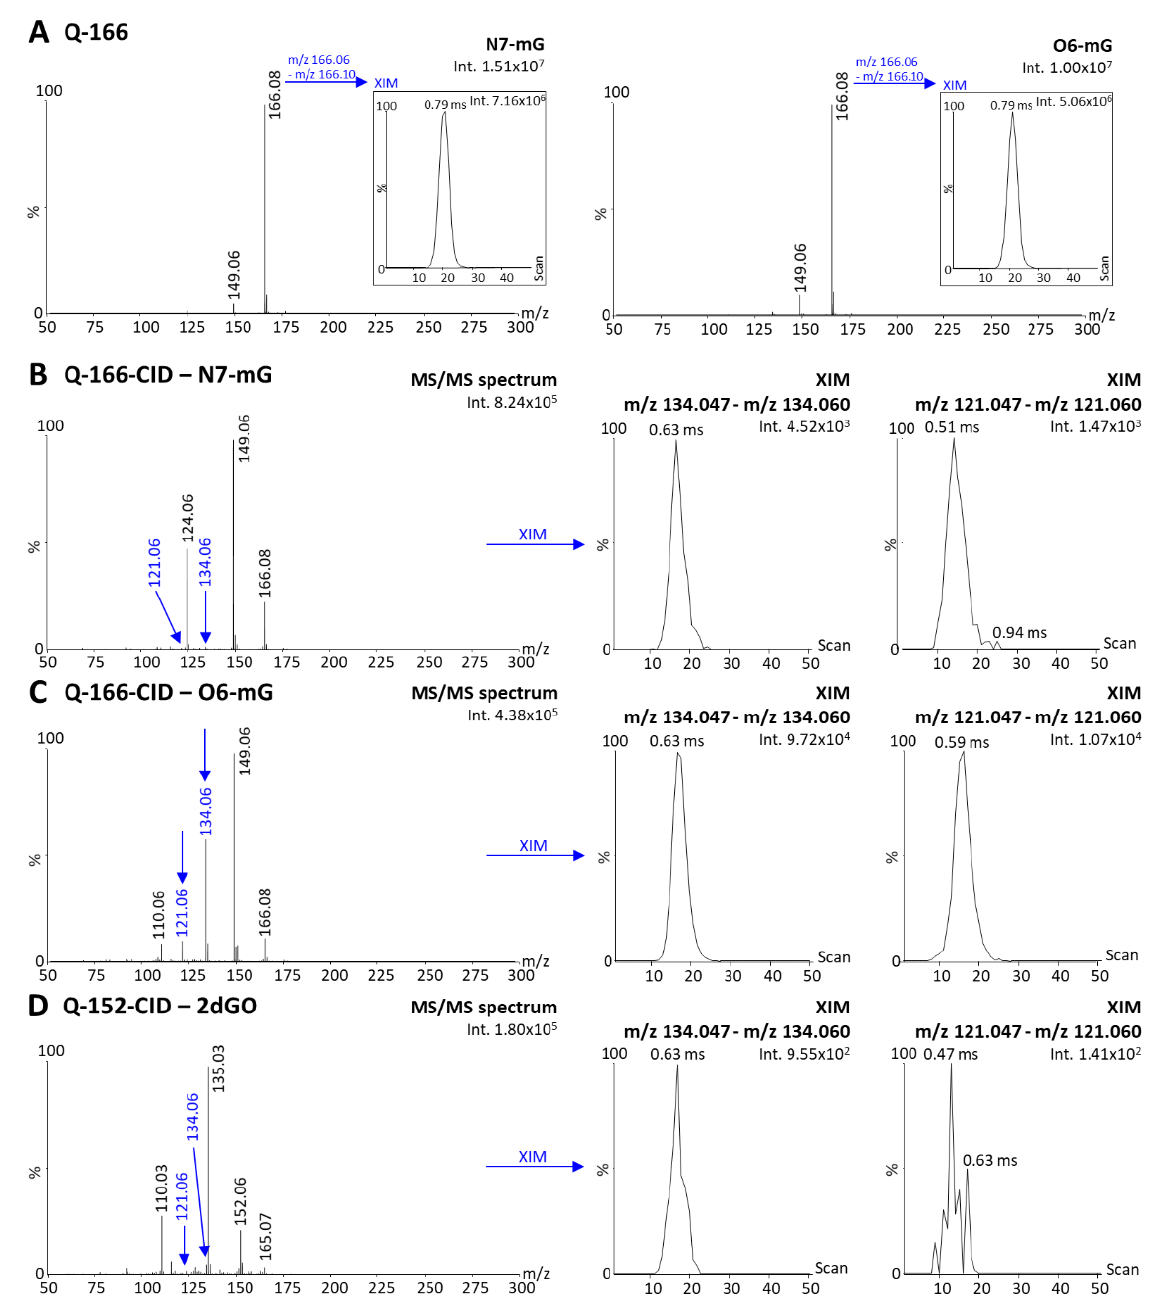
Figure 6. Desorption electrospray ionization (DESI) — ion mobility (IM) mass spectra of N7-methylguanine (N7-mG) and the purine fragment of O6-methyl-2 ’ deoxyguanosine (i.e., O6-mG) acquired with the quadrupole focused on m/z 166 without collision energy (method Q-166) and extracted ion mobilograms (XIM) of the parent peaks (m/z range 166.06 – 166.10) ( A ). DESI-IM-MS/MS spectra of N7-mG ( B ), O6-mG ( C ), and 2′ -deoxyguanosine (2dGO, ( D )) stock so- lutions 0.5 µg/mL in MeOH/H 2 O 1:1 acquired with the quadrupole focused on the m/z 166 (N7-mG and O6-mG) or m/z 152 (2dGO) and 20 – 25 V collision energy for fragmentation (methods Q-166-CID and Q-152-CID). XIM of fragments peaks at m/z 134.06 and m/z 121.06 were extracted from each MS/MS spectrum. Maximum intensities are given in arbitrary units (a.u.) on the top right corner of each spectrum and zoomed view.